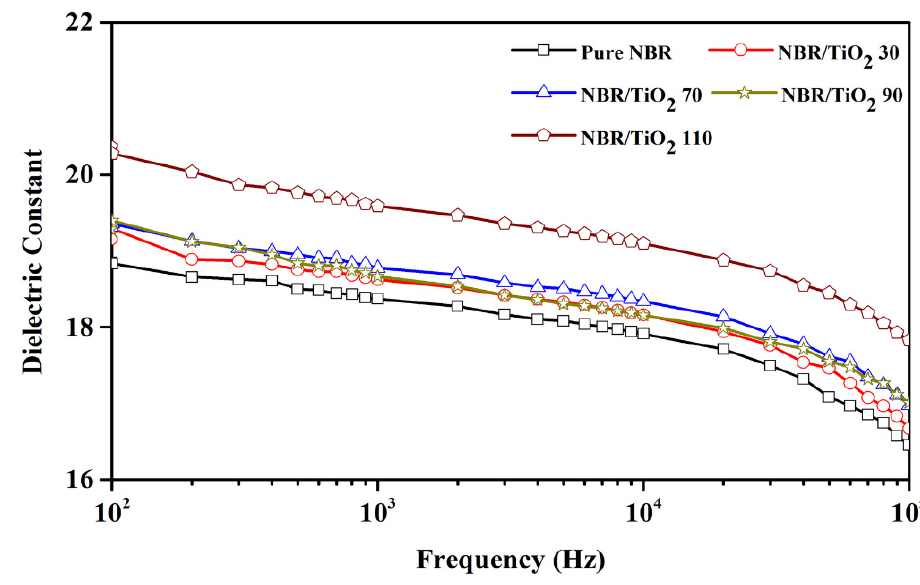
Figure 6. Dielectric constant of TiO 2 -filled NBR composites with various TiO 2 loadings.